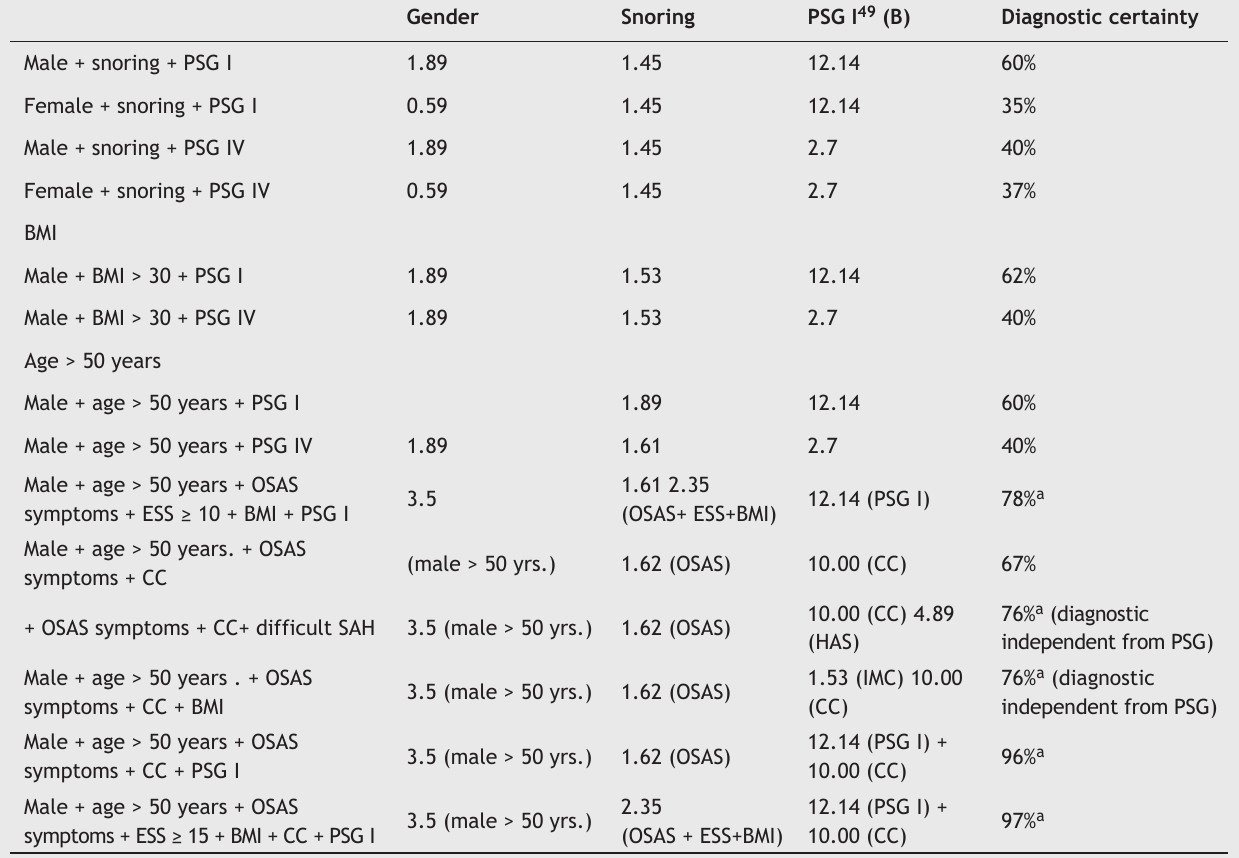
Table 5 Examples of association of signs and symptoms, physical examination, and polysomnography to diagnose OSAS in a population with low prevalence of disease (estimated at